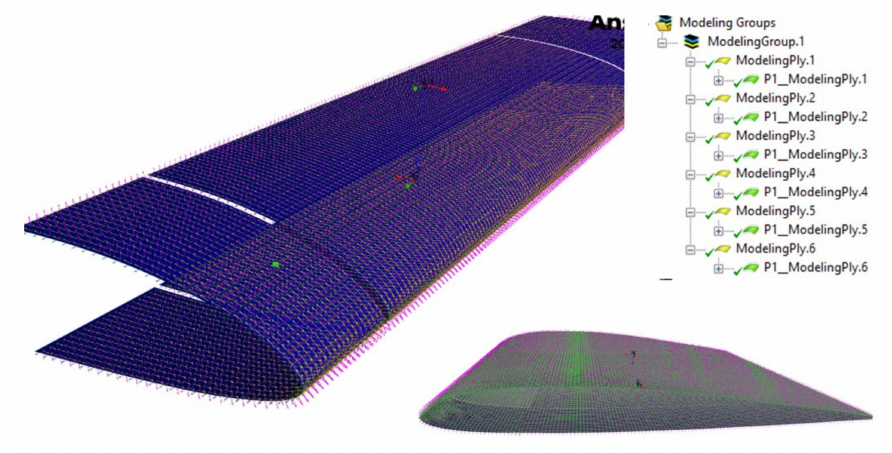
Figure 19. Modeling of the assigned laminated composite material components with the orientation